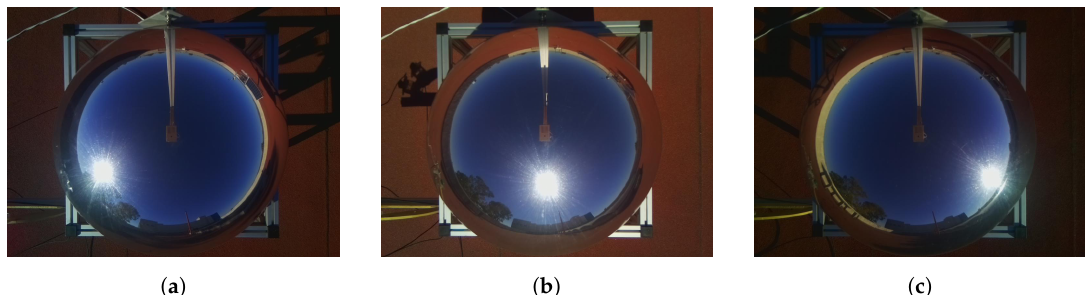
Figure 12. Representative examples with full clear-sky day conditions. ( a ) shows an image taken at 9:00, ( b ) shows an image taken at 13:00, and finally, ( c ) shows an image taken at 17:00.